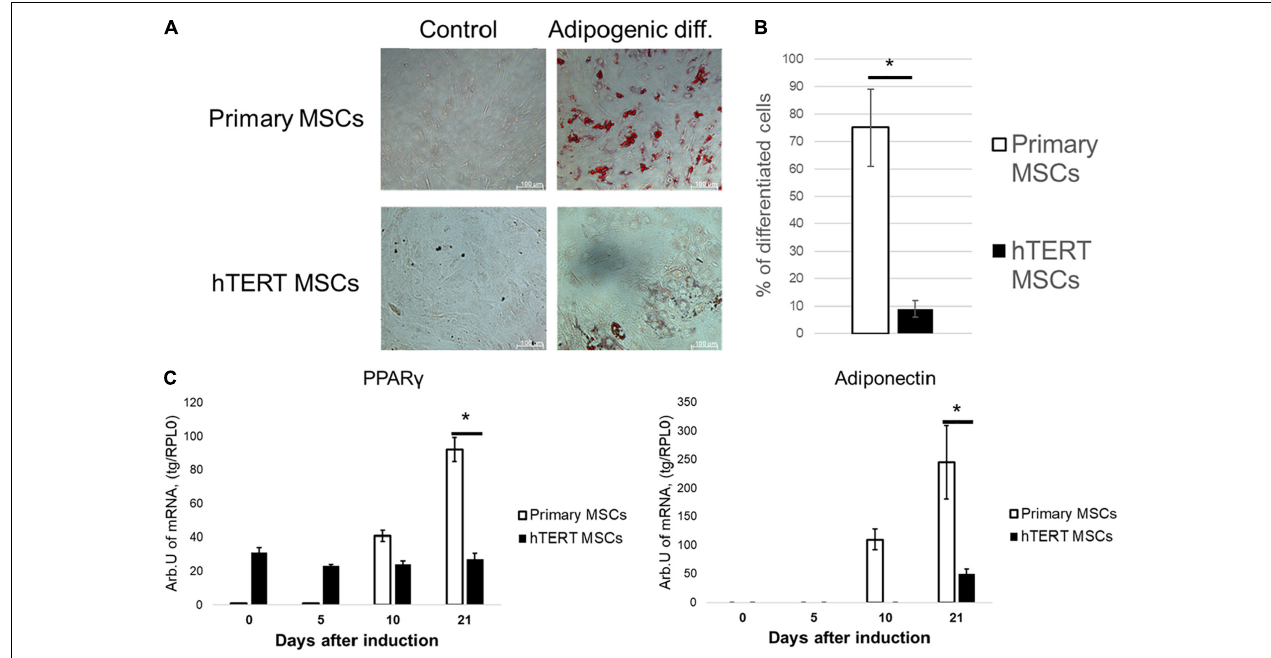
FIGURE 3 | Human adipose-derived primary MSCs and hTERT-MSCs demonstrate significant differences in adipogenic potential. MSC differentiated into adipocytes (Oil Red O staining, “Adipogenic diff.”) under inductive conditions. Groups “control” related to the cells cultured in standard conditions without differentiation induction. (A) Representative images, phase-contrast microscopy. (B) Relative efficiency of adipogenic differentiation of primary MSCs and hTERT-MSCs. (C) Temporal dynamic of marker gene expression during differentiation of MSCs and hTERT-MSC. Results are presented as mean ± SD, n = 8 independent experiments on primary MSCs from four different donors. *Mann–Whitney U test, p <